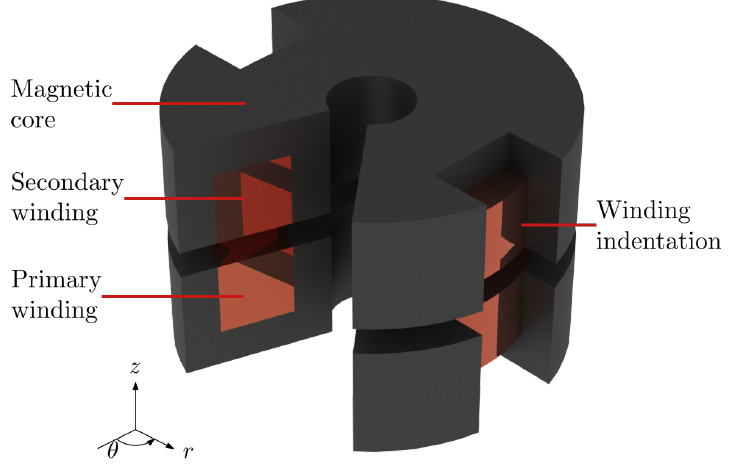
Figure 1. Wedge-shaped cross-sectional view of an axially gapped cylindrical (pot core) transformer, including indication of the various